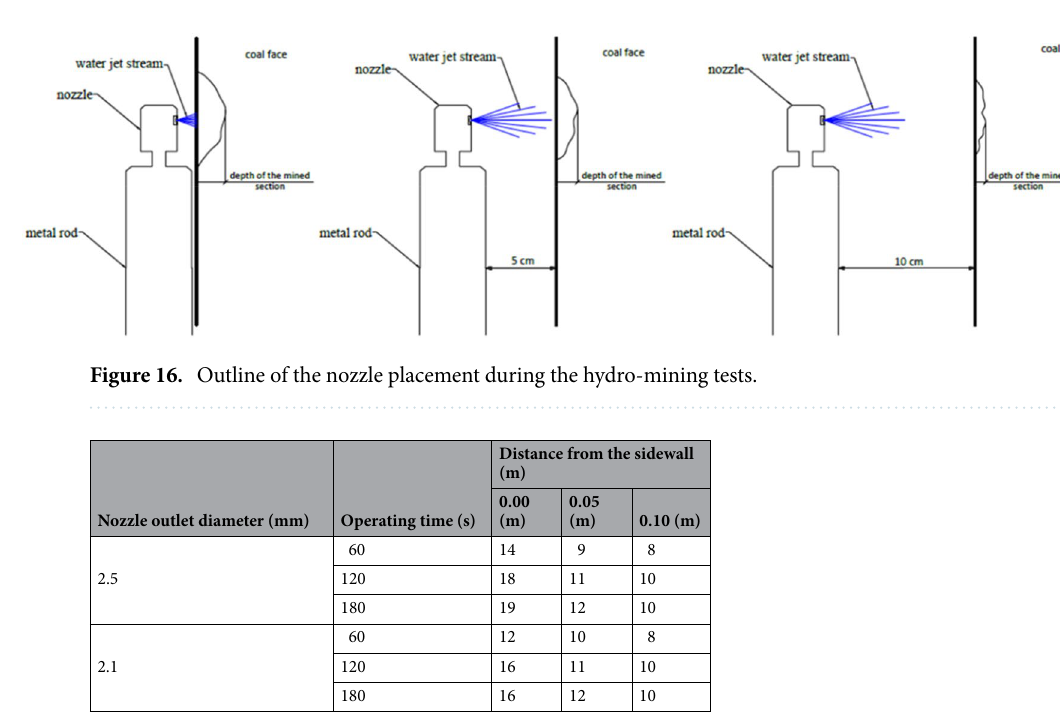
Table 3. The experimental results of the hydro-mining effectiveness in terms of the depth (in cm) of the mined coal face spot.